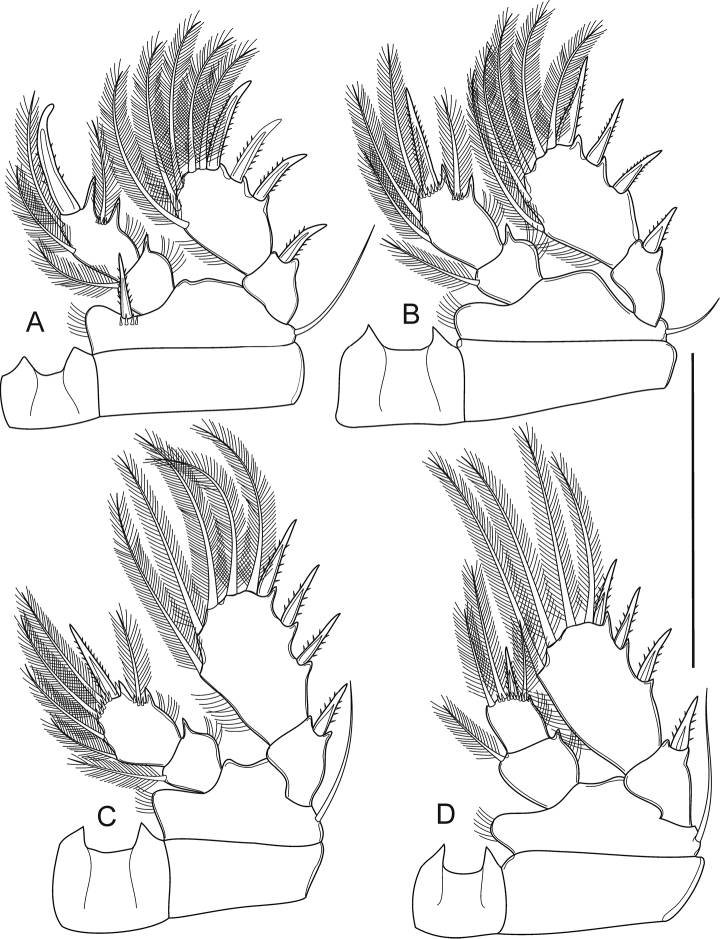
Bryocyclopsasetus sp. n., female: AP1BP2CP3DP4. Scale bar: 50 μm.